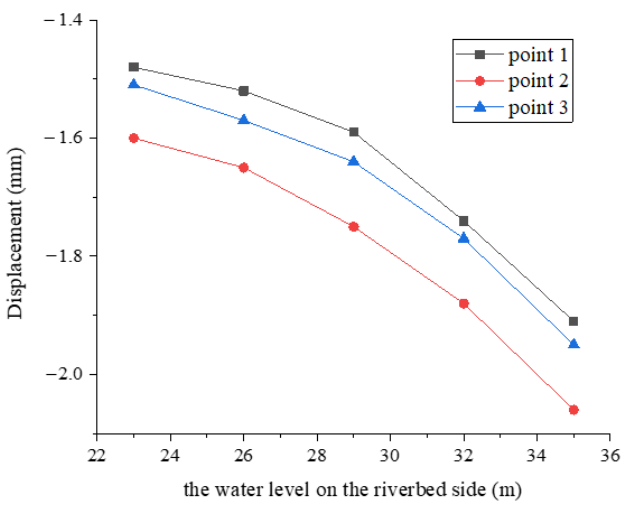
Figure 15. Variation curve of displacement at different monitoring points with the water level on the riverbed side.